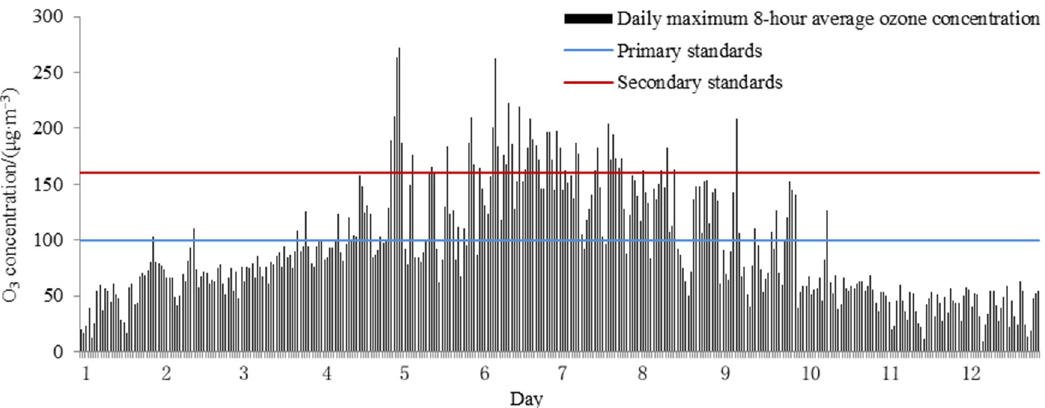
3 concentration.